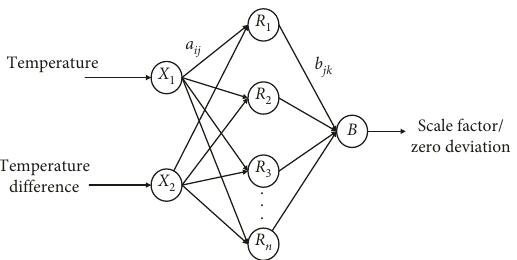
Figure 1: Temperature compensation model of BP neural